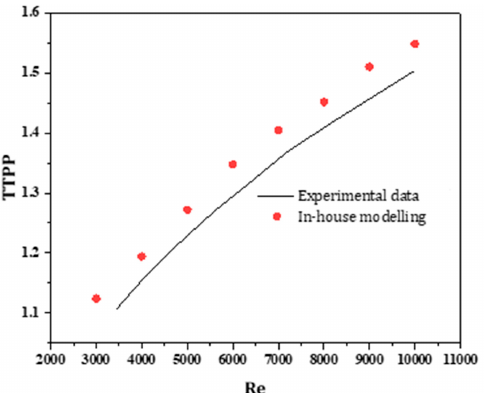
Figure 3. Temperature difference across a smooth SAH (𝑇 (cid:3028)(cid:3042) −𝑇 (cid:3028)(cid:3036) ) versus daytime hours using our in-house model predictions and experimental data inferred from [25].